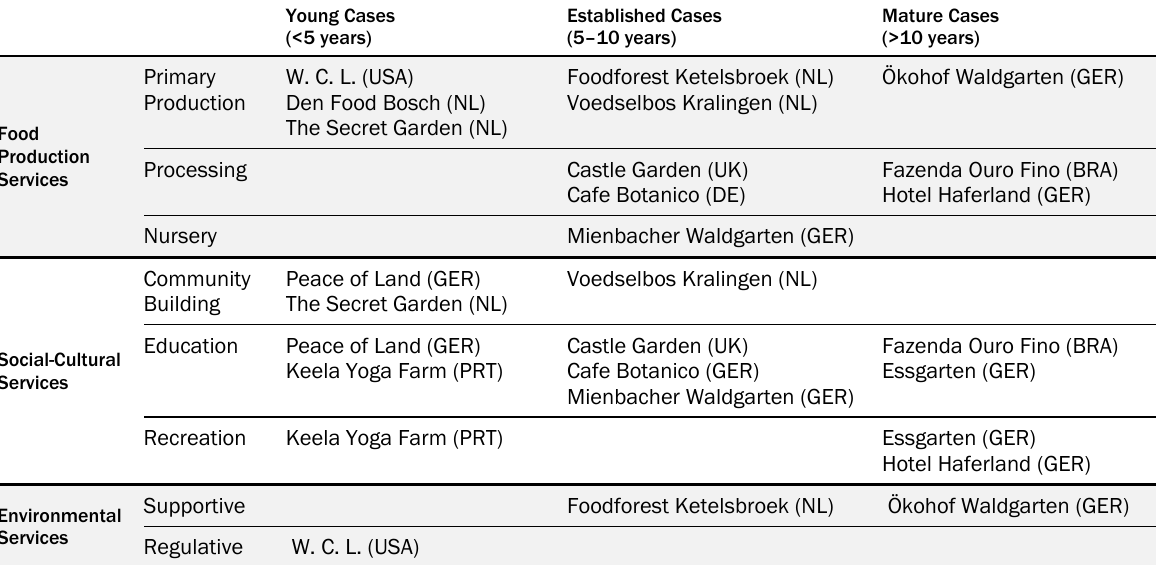
Table 2. Overview of 14 Exemplary Food Forests (Two Main Services Indicated per